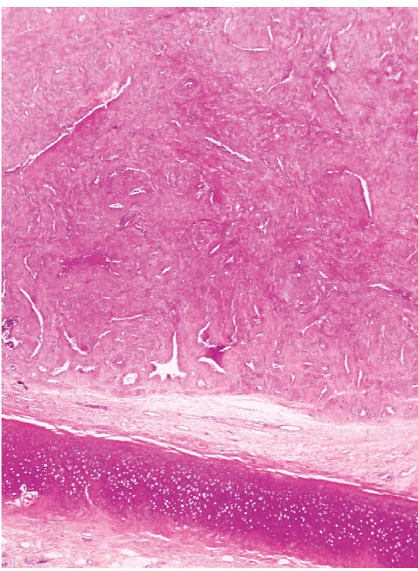
Figure 2: The dermal tumor spares the underlying ear cartilage (original magnification: × 40).